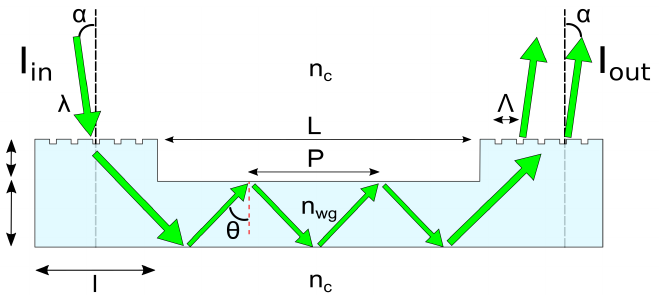
Figure 1. Schematic representation of the opto-geometric parameters of a planar grating coupled waveguide. Light is coupled on the left side with an integrated grating which is raised (d) from the waveguide core due to our fabrication process.